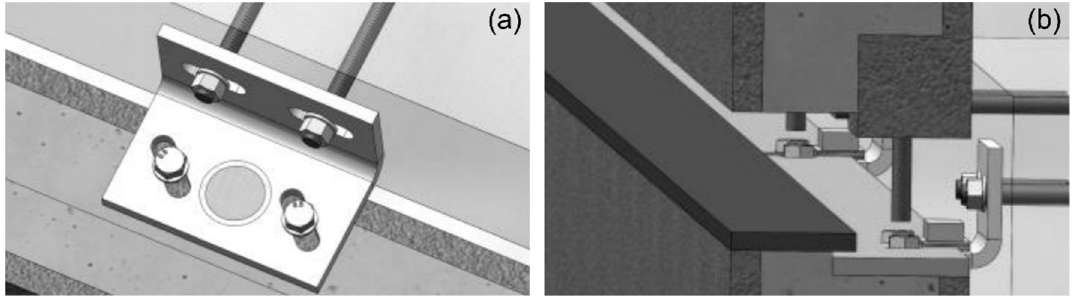
Figure 3. Details of upper ( a ) and lower ( b ) element anchors.